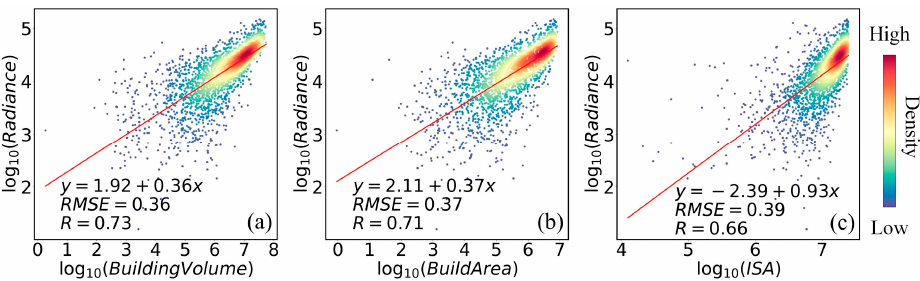
Figure 5. The linear regression between urban form indicators and the NTL data at the grid scale (5 km) from 38 cities in China. ( a ), building volume; ( b ), building area; ( c ), ISA.